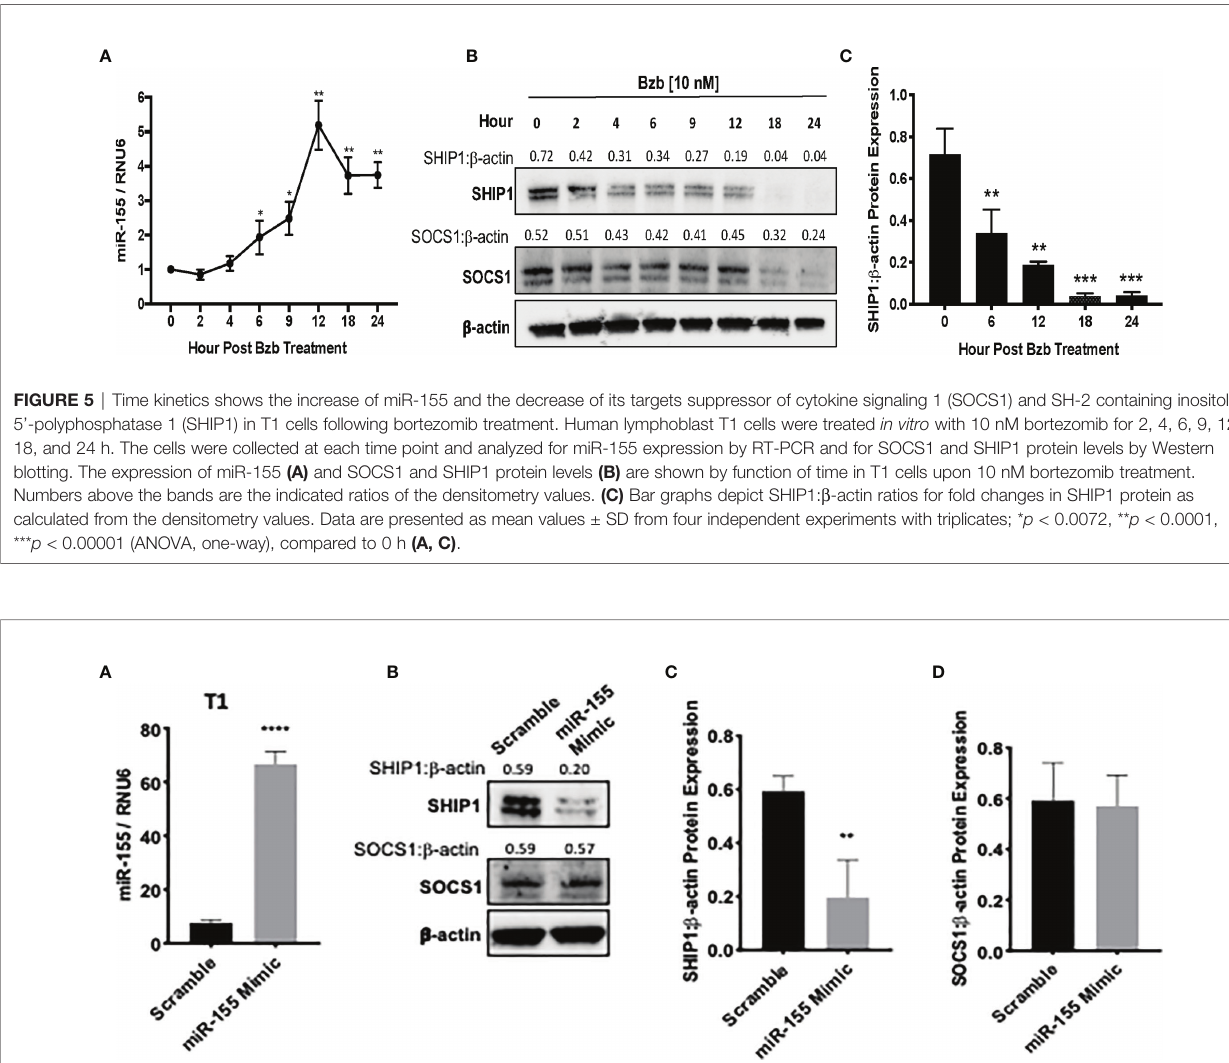
FIGURE 6 | miR-155 overexpression decreases SH-2 containing inositol 5 ’ -polyphosphatase 1 (SHIP1) levels. T1 cells were treated for 24 h with either hsa-miR- 155-5p mimic or scramble siRNA plasmids. The expression of miR-155 (A) and suppressor of cytokine signaling 1 (SOCS1) and SHIP1 proteins (B) are shown in T1 cells 24 h post miR-155 mimic and scramble plasmid transfection. Numbers above the bands are the indicated ratios of the densitometry values. Bar graphs depict SHIP1: b -actin ratios (C) or SOCS1: b -actin ratios (D) for fold changes in SHIP1 or SOCS1 proteins as calculated from the densitometry values. Data in bar graphs are presented as mean values ± SEM from four independent experiments, each with triplicates. ** p < 0.002, **** p < 0.0001 for miR-155 mimic versus scrambled control (Unpaired t -test, two